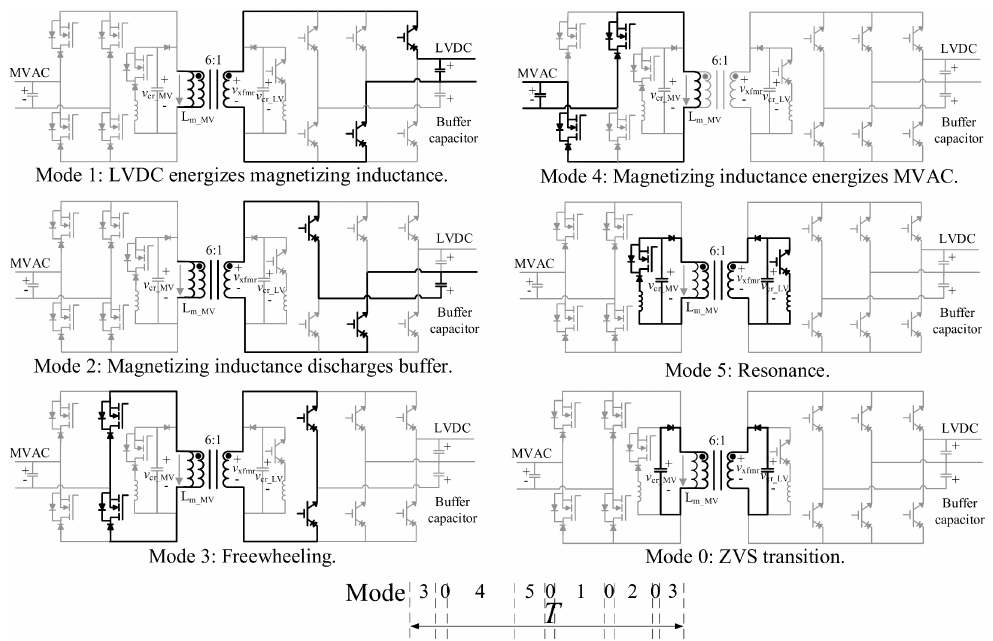
Figure 9. Switching states and switching sequence representation regarding the S4T adopted in [33] (figure adapted from